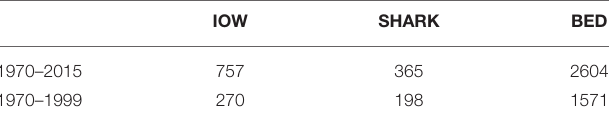
TABLE 4 | Total amount of stations (“station” is a vertical profile sampled; it could be just temperature measured every few centimeters or a full set at standard depths; it could also include multi-day intensive stations with profiles taken every few hours) in different datasets: (1) The data archive (http://iowmeta.io- warnemuende.de) of the Leibniz Institute for Baltic Sea Research Warnemünde (IOW), (2) the Swedish Ocean Archive (SHARK, https://sharkweb.smhi.se/) operated by the Swedish Meteorological and Hydrological Institute (SMHI), and (3) the Baltic Environmental Database (BED, http://nest.su.se/bed) at Stockholm